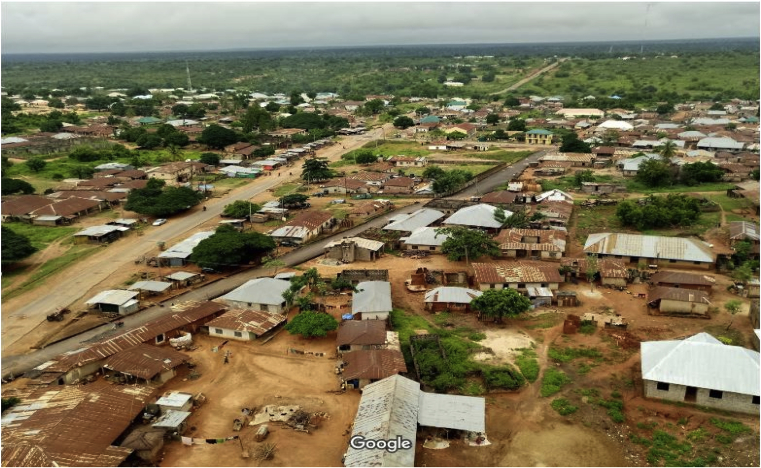
Aerial view of Lade II, Pategi [45].